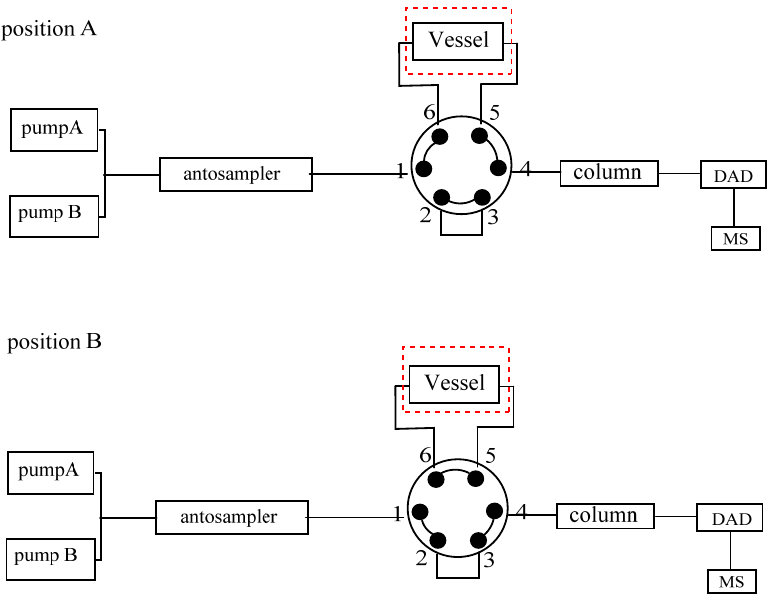
Figure 6. The schematic of OLE–LC–DAD–IT–TOF–MS. Each measurement is divided into two phases, including extraction (0–5 min) and elution (5–42 min) phases via switching the electronic valve from position I to position